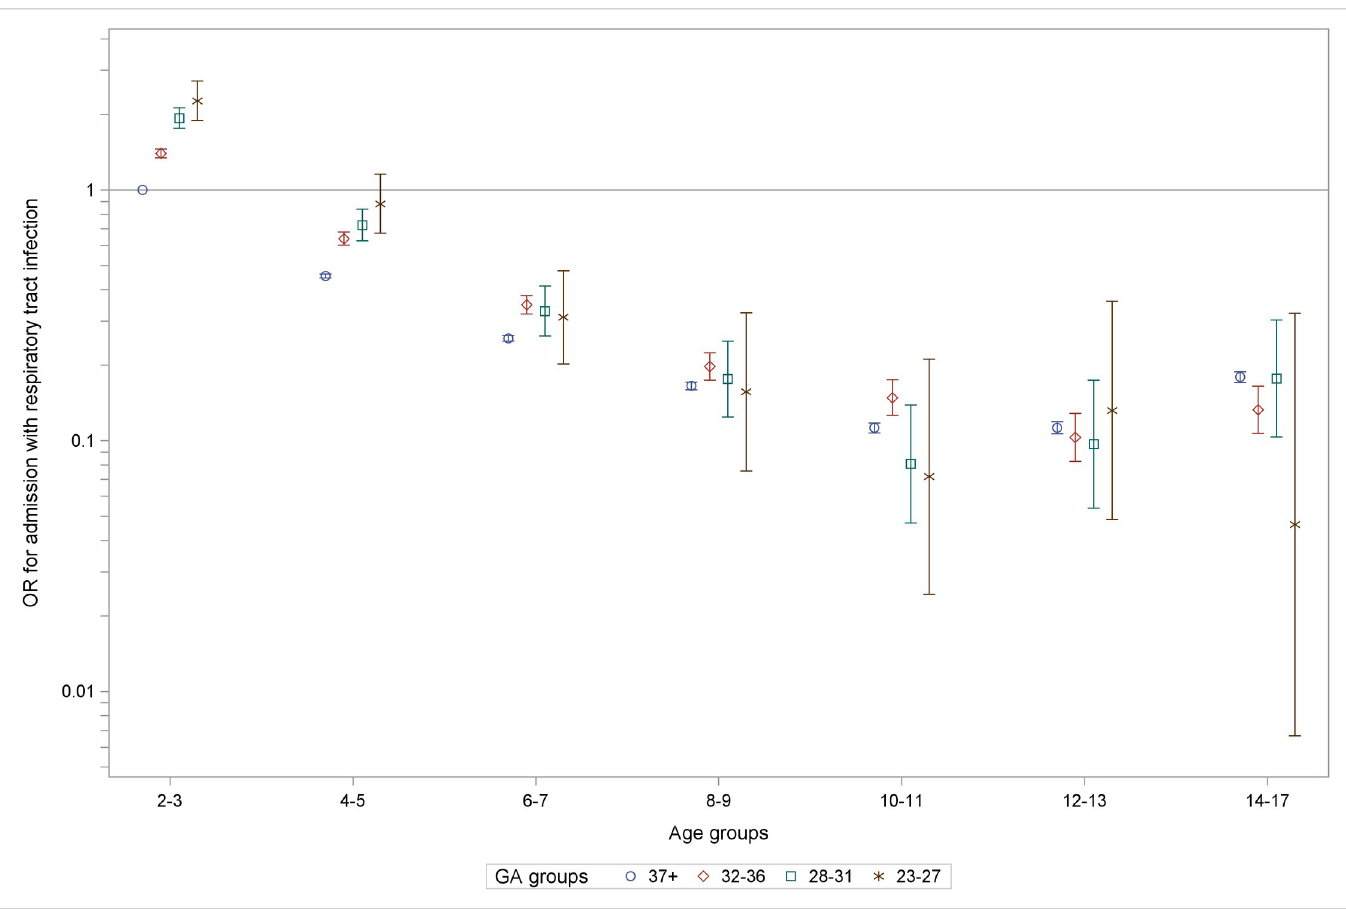
Fig 4. ORs for hospital admissions per GA-group illustrating gradual decrease of the GA-effect. The reference group was GA 37+ at age 2–3. Adjusted for calendar year, sex, SGA, maternal educational level, cesarean section, older sibling, acute respiratory disease and bronchopulmonary disease. OR: odds-ratio, GA: gestational age.